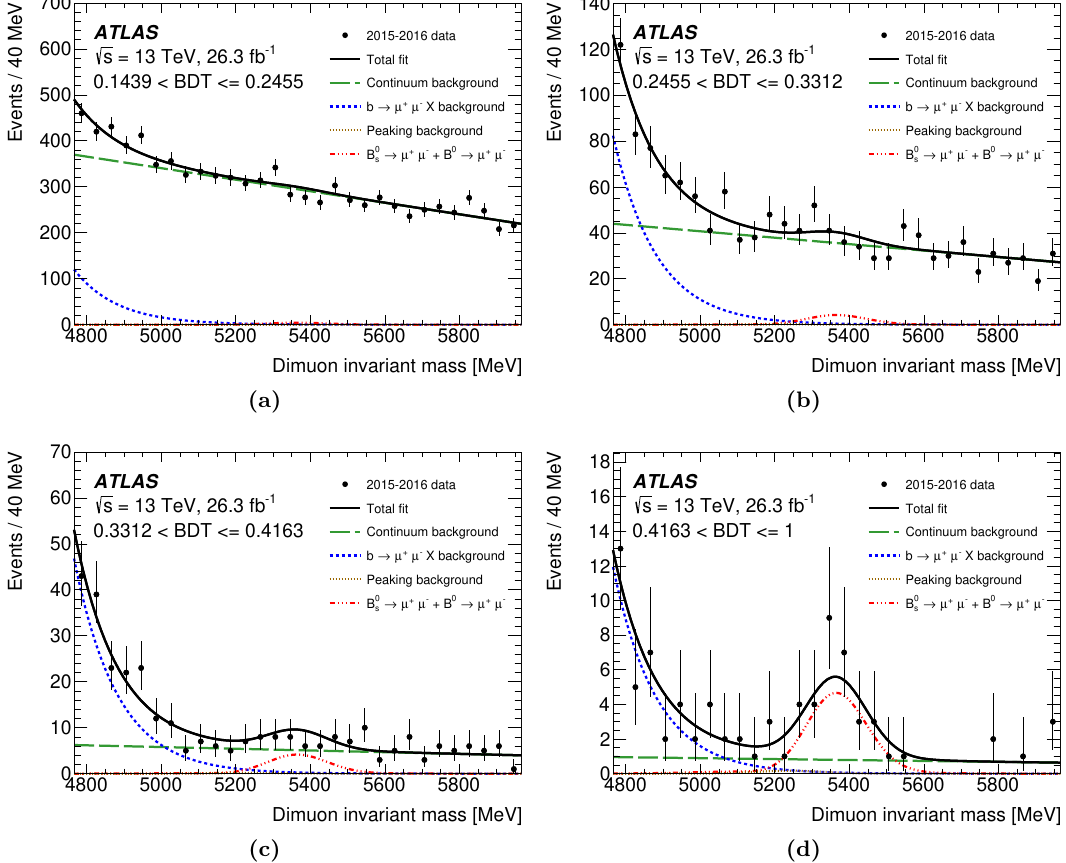
Figure 8. Dimuon invariant mass distributions in the unblinded data, in the four intervals of BDT output. Superimposed is the result of the maximum-likelihood (cid:12)t. The total (cid:12)t is shown as a con- tinuous line, with the dashed lines corresponding to the observed signal component, the b ! (cid:22)(cid:22)X background, and the continuum background. The signal components are grouped in one single curve, including both the B 0 ! (cid:22) + (cid:22) (cid:0) and the (negative) B 0 ! (cid:22) + (cid:22) (cid:0) component. The curve rep- s resenting the peaking B 0 ! hh 0 background lies very close to the horizontal axis in all BDT ( s )